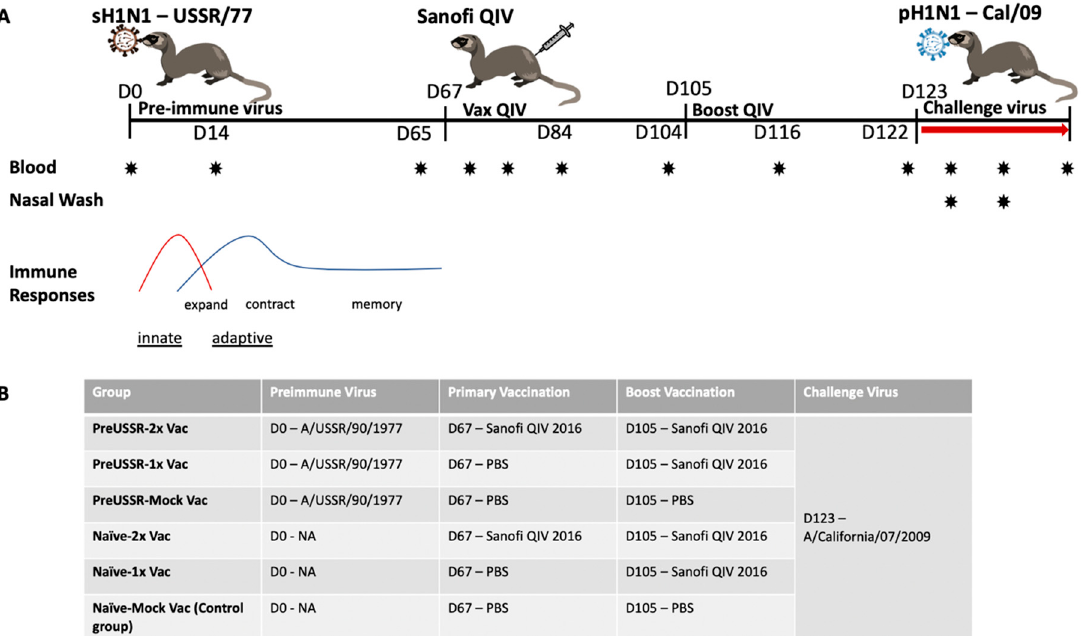
Figure 1. Study timeline and experimental group design for the investigation of influenza immune history and regulation of host responses to Sanofi FLUZONE ® QIV. ( A ) The study time shows the time course of infections and vaccinations in relation to the general dynamic trends of the innate and adaptive systems. ( B ) The Table depicts the experimental groups and corresponding preimmune virus, vaccine course, and challenge.